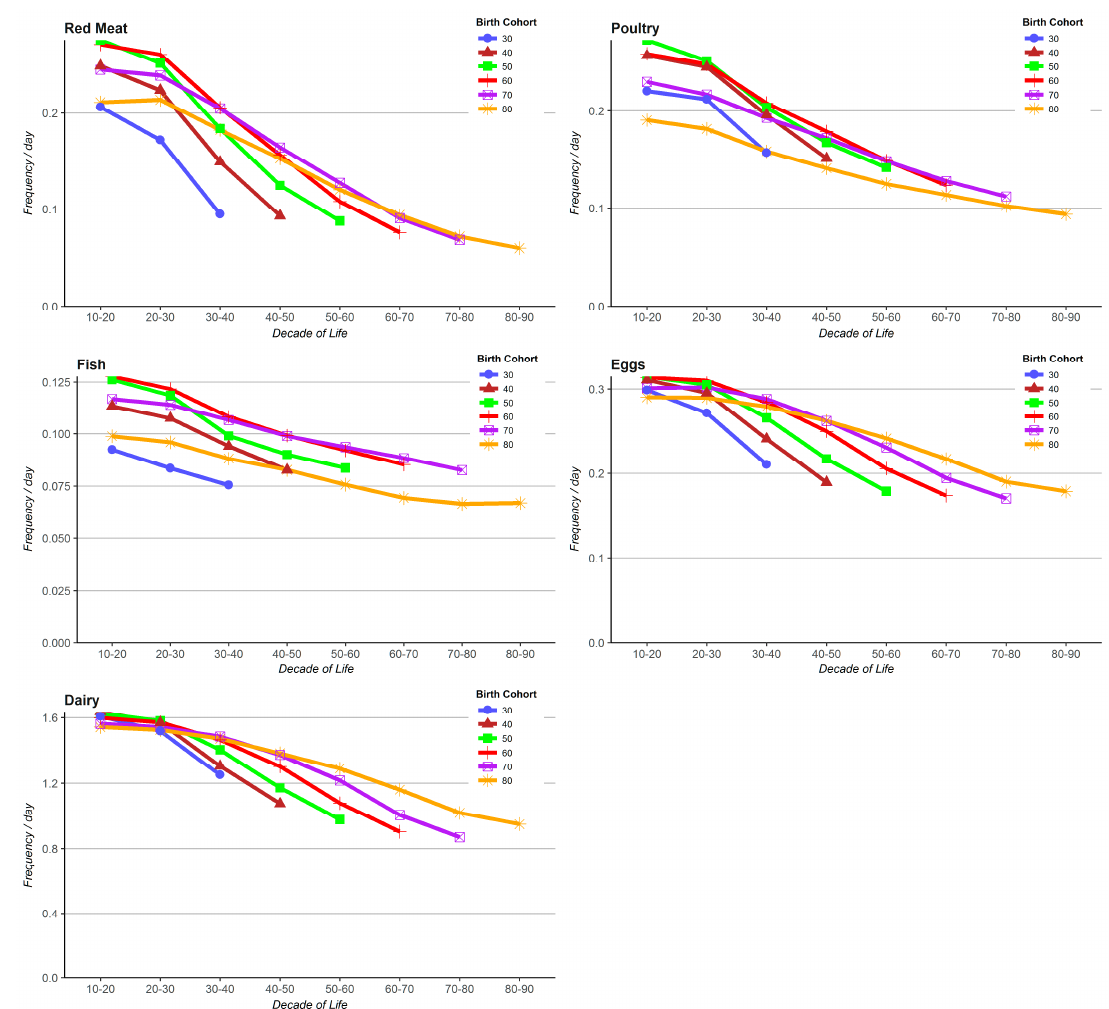
Figure 1. Consumption of animal products at particular ages during the observed lifetimes for different birth cohorts of the Adventist Health Study-2 ( N = 51.082). Adjusted for gender and race.